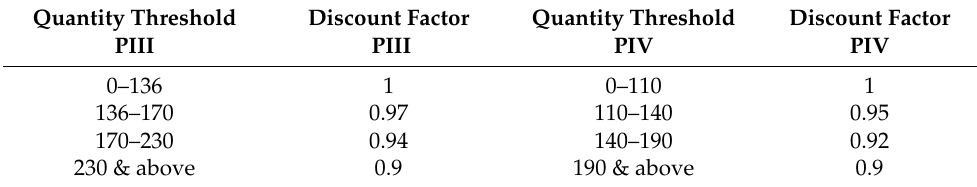
Table A9. Quantity threshold and discount factor for PIII and PIV for all periods.